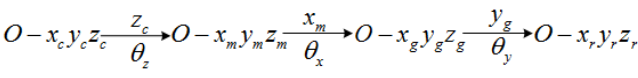
Figure 2. Angular position relationship among the body